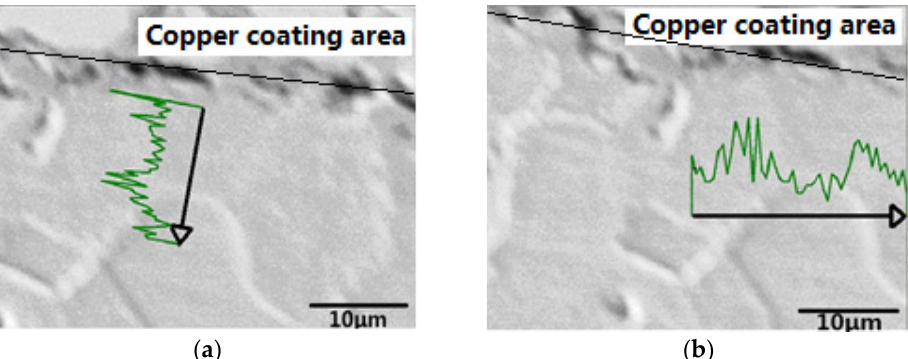
Figure 5. The line scanning of the sample at 1000 °C: ( a ) the grain near to the copper coating area; ( b ) the grain not near to the copper coating area.